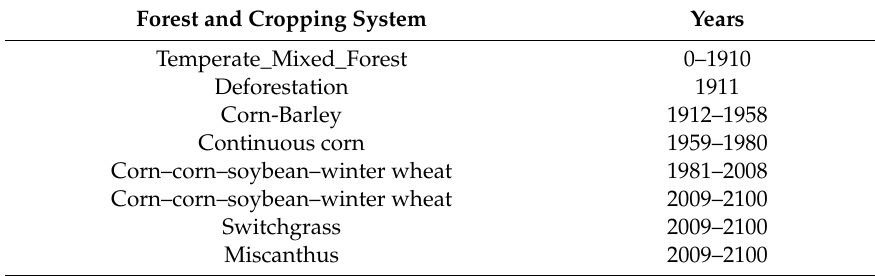
Table 2. Land use history data for Elora, ON. Canada, applied in DayCent